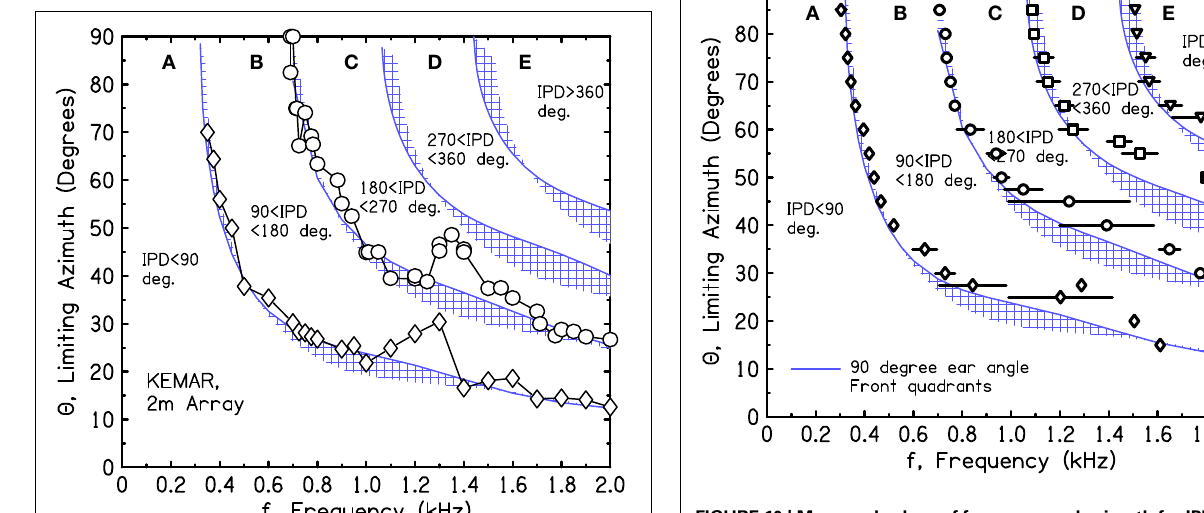
FIGURE 10 | Measured values of frequency and azimuth for IPDs of 90 ◦ , 180 ◦ , 270 ◦ , and 360 ◦ for a rotated KEMAR manikin. Values were measured in left and right quadrants in front of the head using a single source. The average of the two quadrants is shown together with an error bar two standard deviations in overall length. Long error bars indicate regions of non-monotonic